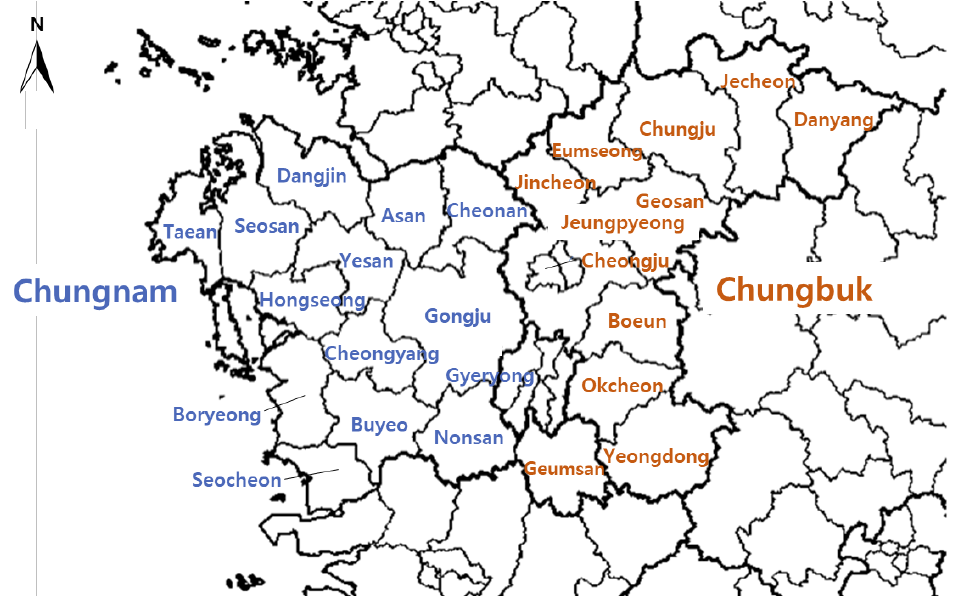
Figure 1. Administrative map of Chungcheong region.